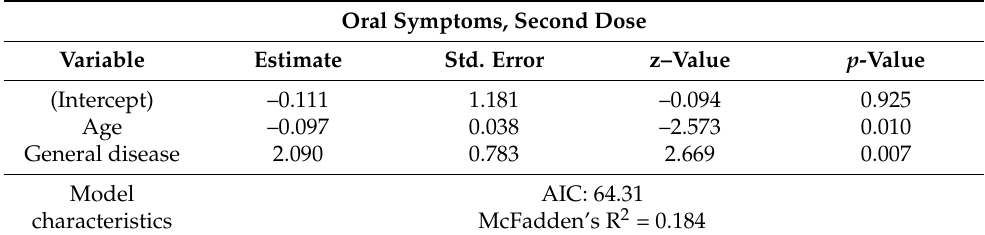
Table 5. Logistic model results for occurrence of oral symptoms after the second dose.